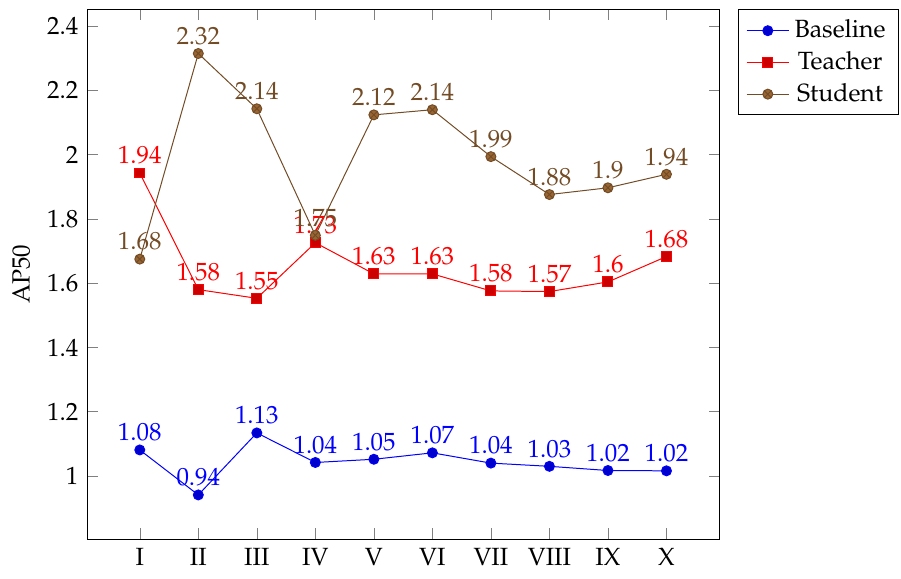
Figure 12. 10 last model weight comparison on BG COVID